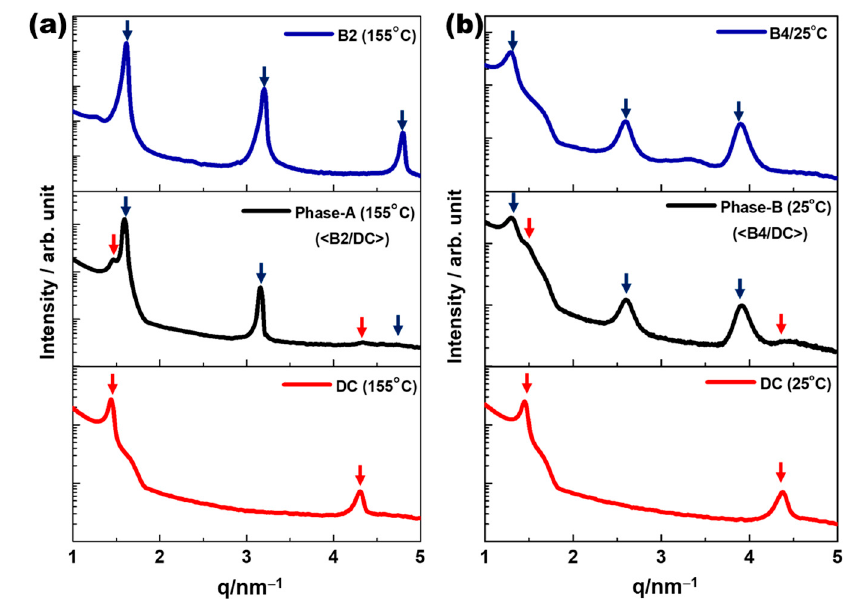
Figure 3. ( a ) A typical small-angle-region XRD profile obtained over a temperature range corresponding to Phase-A and XRD profiles of pure B2 (originating from BC molecules) and pure DC (originating from BCMP). ( b ) A typical small-angle-region XRD profile obtained over a temperature range corresponding to Phase-B and XRD profiles of pure HNF B4 (originating from BC) and pure DC (originating from BCMP).